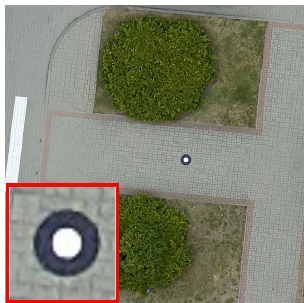
Figure 3. Signalized GCP no. 116 on image fragment captured using Phase One iXU-RS 1000 camera